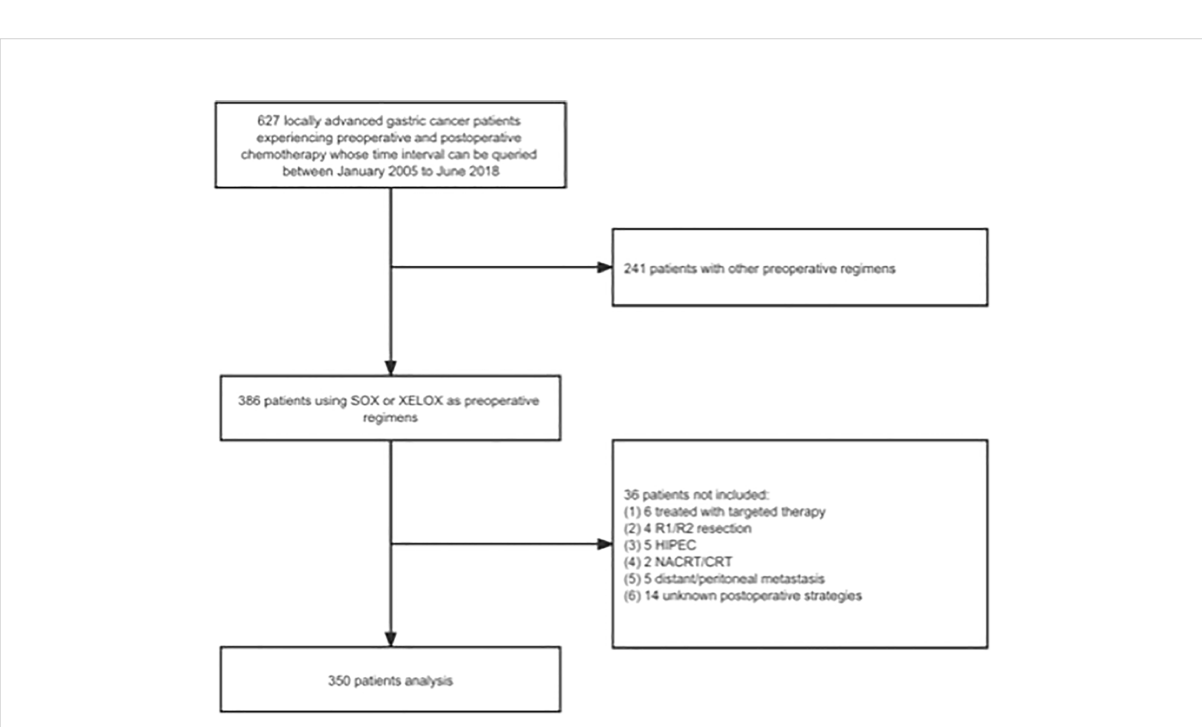
FIGURE 2 The study fl ow chart. SOX, S-1 plus oxaliplatin; XELOX, capecitabine plus oxaliplatin; HIPEC, hyperthermic intraperitoneal chemotherapy; NACRT, neoadjuvant chemoradiation therapy; CRT, chemoradiation therapy.